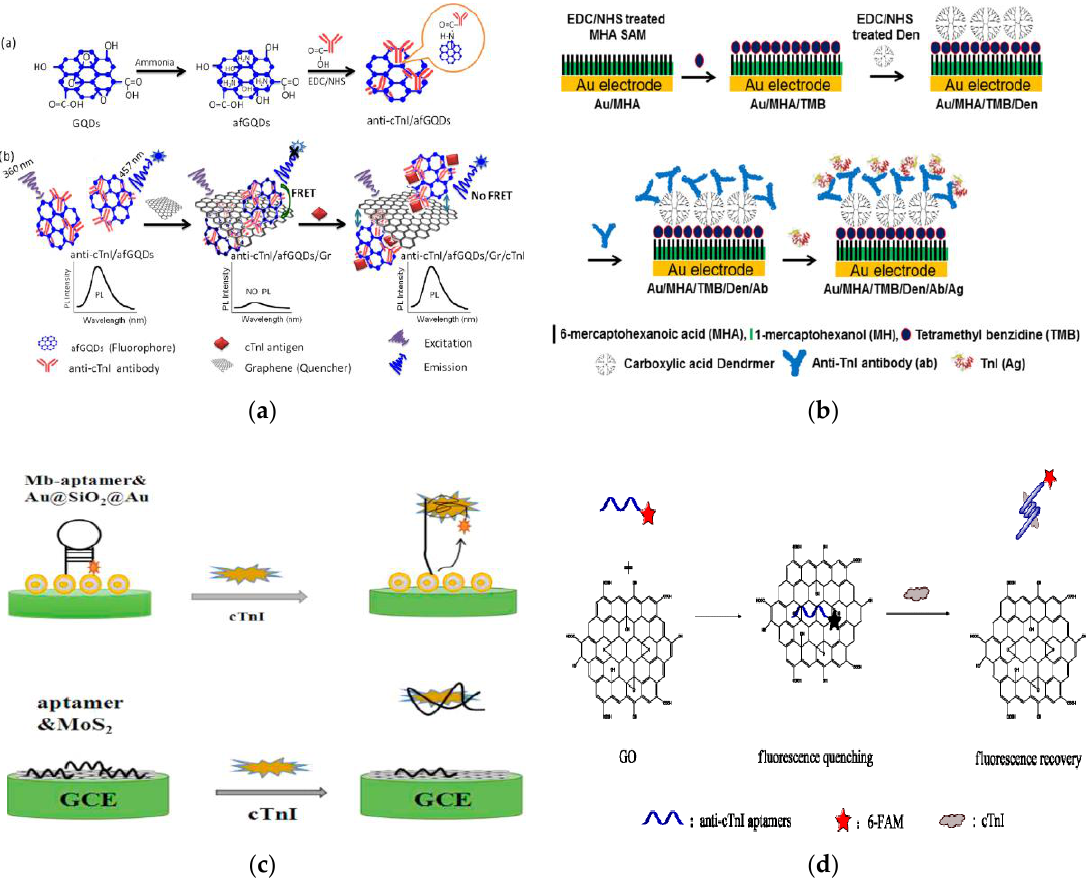
Figure 5. Label-free and novel labelling techniques [134,136–138]. ( a ) Detection process scheme for graphene quenching of afGQD fluorophores and subsequent release of Ab upon cTnI binding; ( b ) Fabrication scheme of a ‘label-free’ electrochemical-based biosensor; ( c ) Electrochemical detection technique utilising a core–shell immobilisation surface and alternative ‘label-free’ detection technique utilising MoS 2 nanosheets for cTnI measurements; ( d ) 6-FAM-modified aptamer dislodged from graphene oxide sheets in the presence of cTnI. (All figures have been re-printed with permission from the publisher).